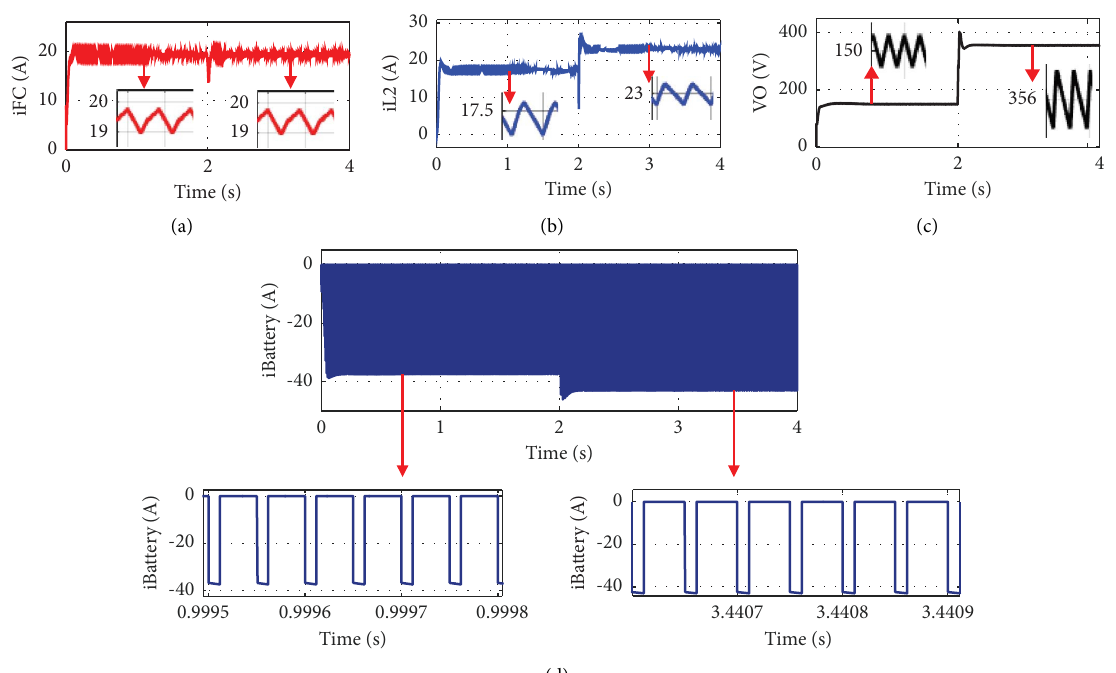
Figure 22: DC-DC converter specifcation in the second mode. (a) Current of FC, (b) current of iL2, (c) output voltage, and (d) current of battery.